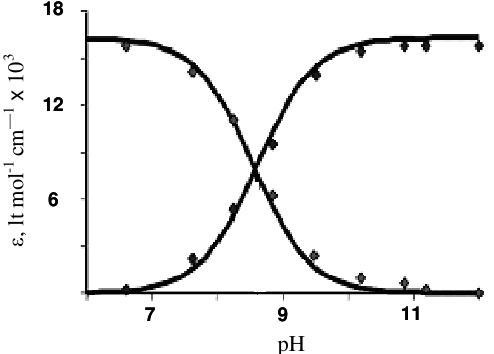
Figure 2. Effect of pH on the absorptivities of 1a at (a) 326 and (b) 370 nm. The solid lines are curv-fitted for pK = 8.6. a